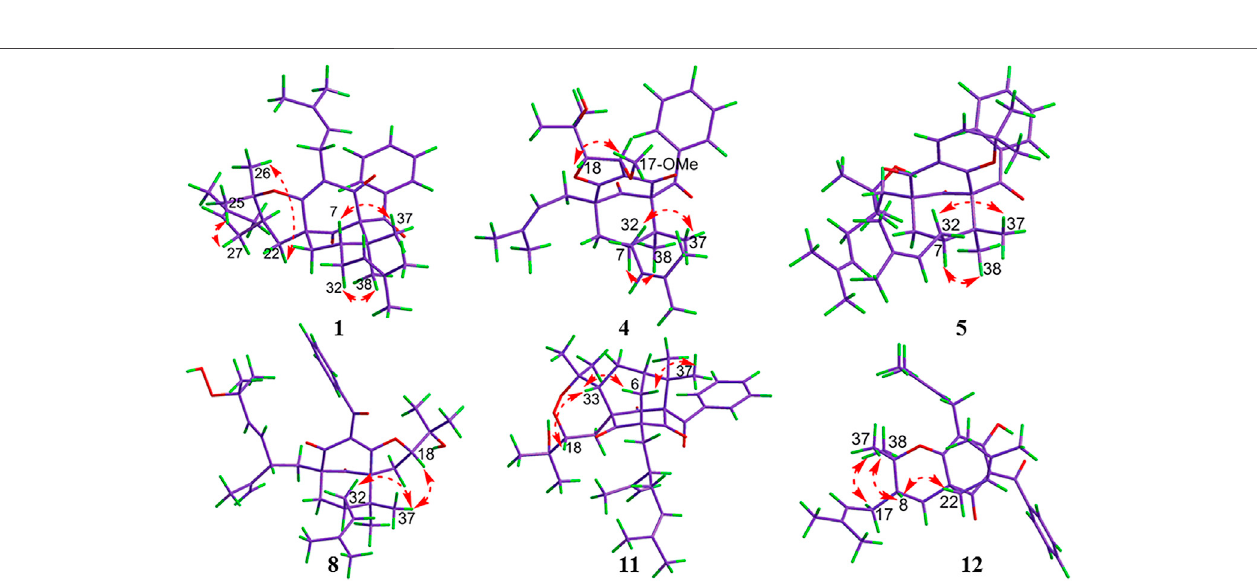
Frontiers in Chemistry |